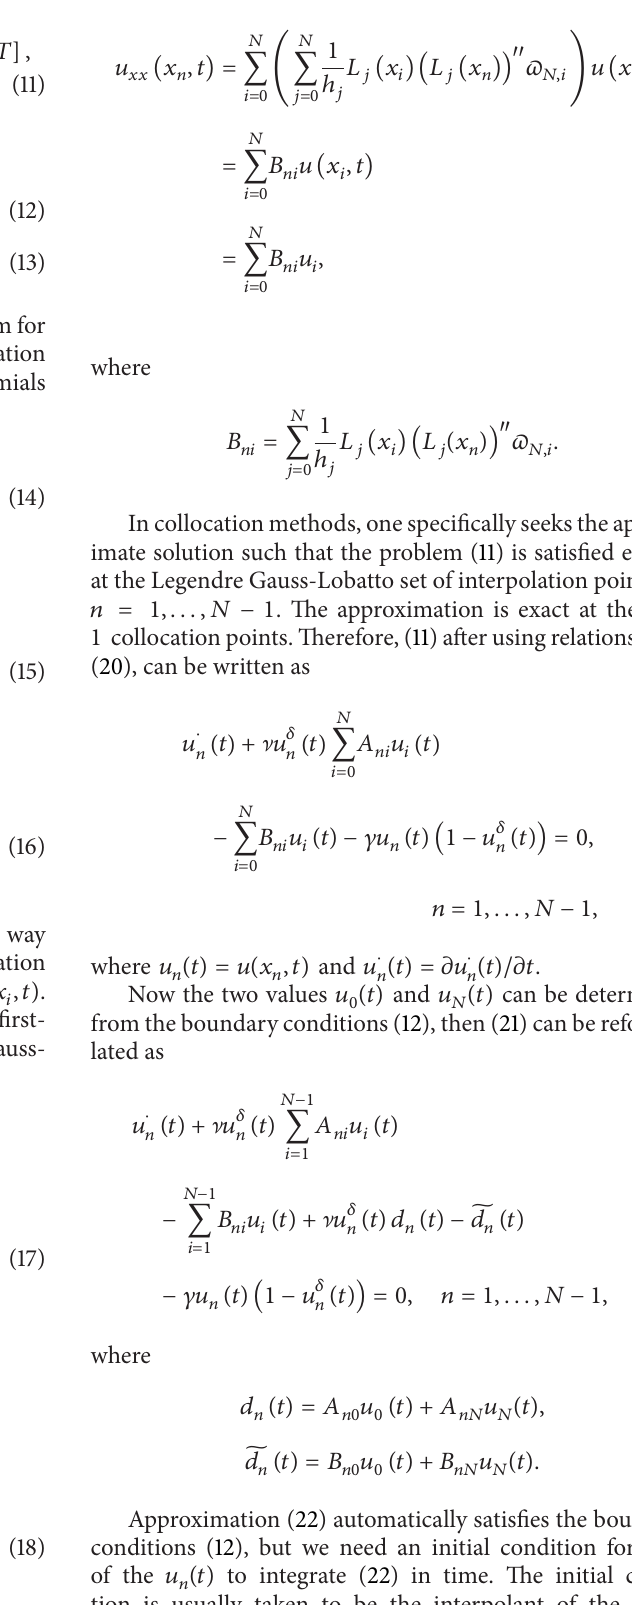
algorithm to solve numerically the generalized Burger-Fisher